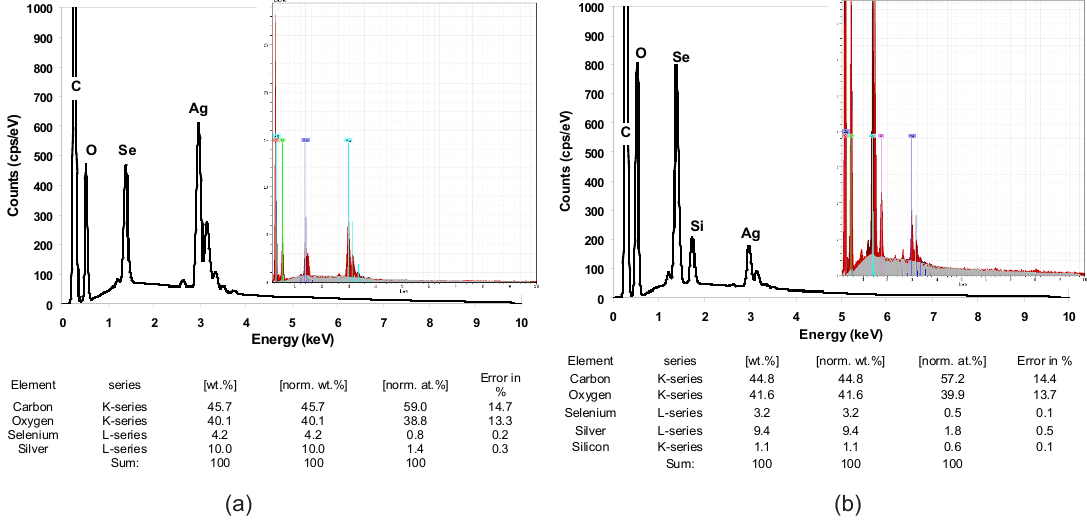
Figure 4. Composition: (a) - of treated surface in Fig. 2 b; (b) - coating microstructure in Fig. 2